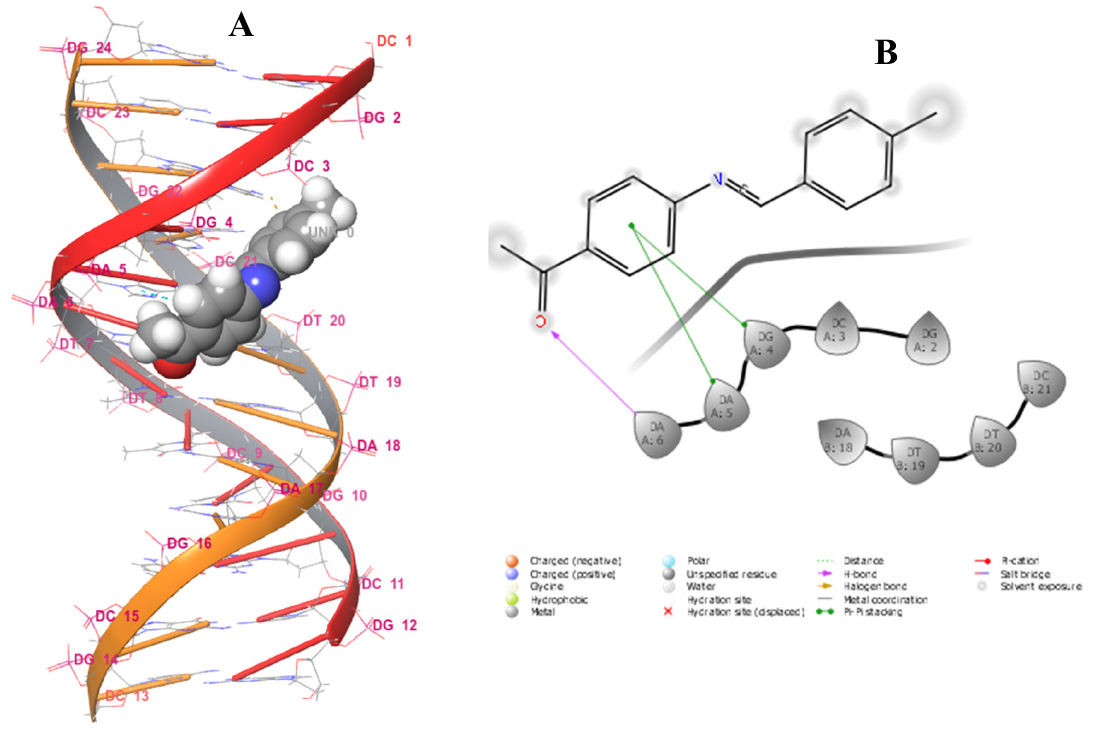
Figure 14. Three-dimensional binding model of 2 with 1BNA ( A ); two-dimensional diagram of 2 and interacting residues ( B).